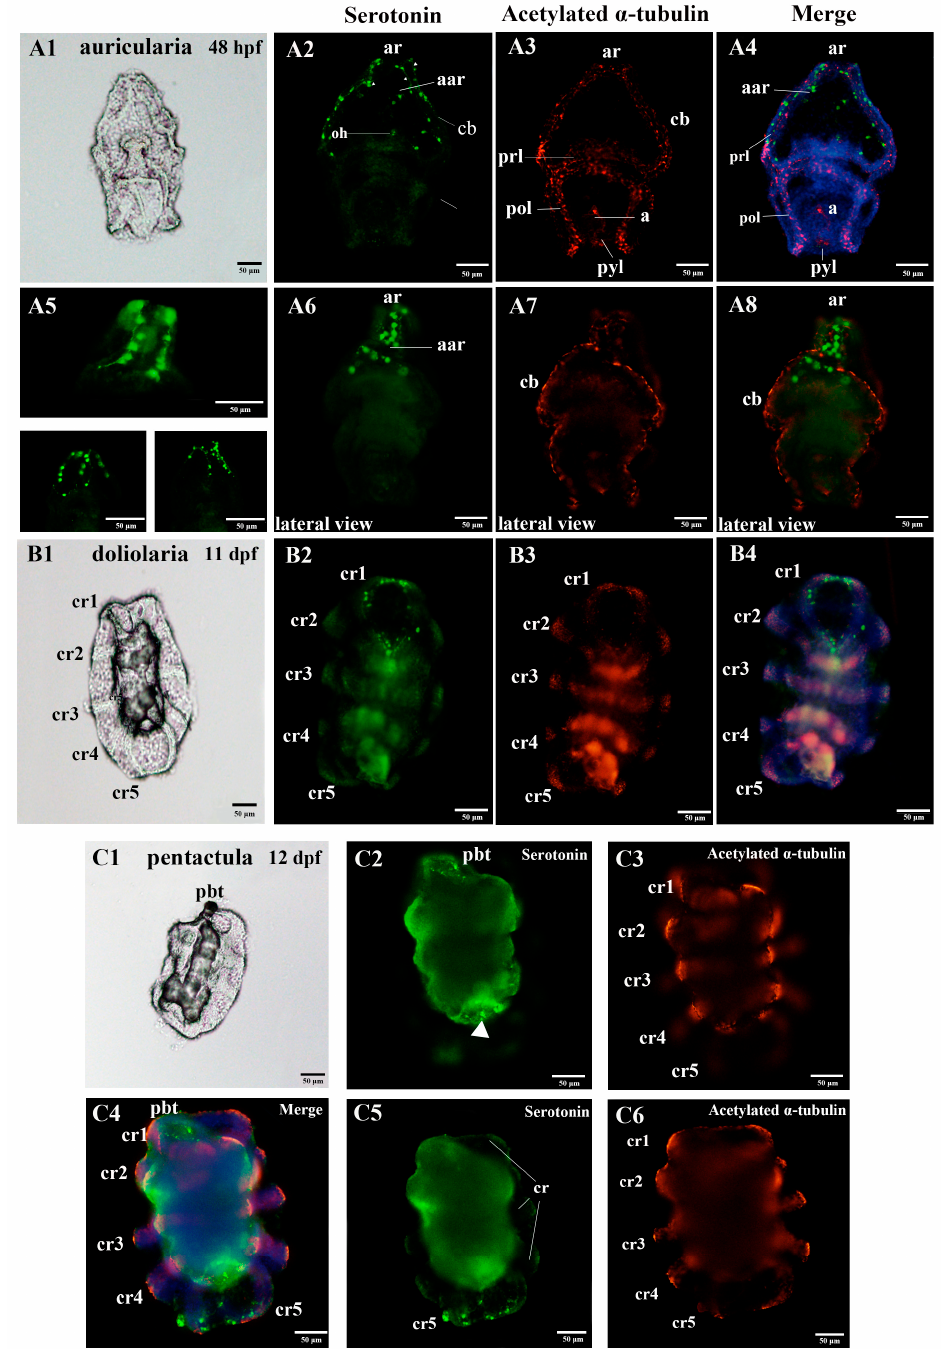
Figure 2. Anatomy diagrams and localization of the nervous system in the larvae of the sea cucumber A. japonicus , using immunofluorescence. ( A1 – A8 ) auricularia; ( B1 – B4 ) doliolaria; ( C1 – C6 ) pentactula. ( A5 ) is a high resolution picture of the anterior region of auricularia stained for serotonin (green). ( A6 – A8 ) are lateral views of the serotonin and acetylated α -tubulin staining. ( C2 , C3 , C5 , C6 ) are pictured by focusing on the different layers, respectively. The labels are: a, anus; aar, anterior apical region; ar, apical ridge; cb, ciliary band; cr, ciliary ring; oh, oral hood; pbt, primary buccal tentacle; pol, posterior loop; prl, preoral loop; pyl, pylorus. Green, serotonin; Red, acetylated α -tubulin. Information of hpf (hours post fertilization) and dpf (days post fertilization) is labelled at the upper right of the anatomy